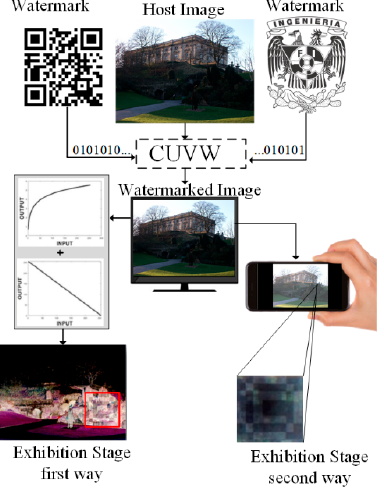
Figure 2. General diagram of the CUVW.